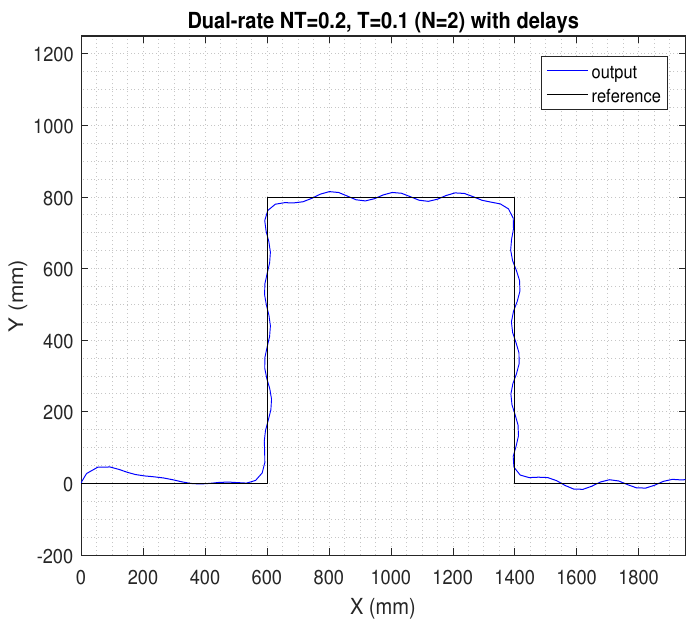
Figure 8. Results for the dual-rate control with delays.